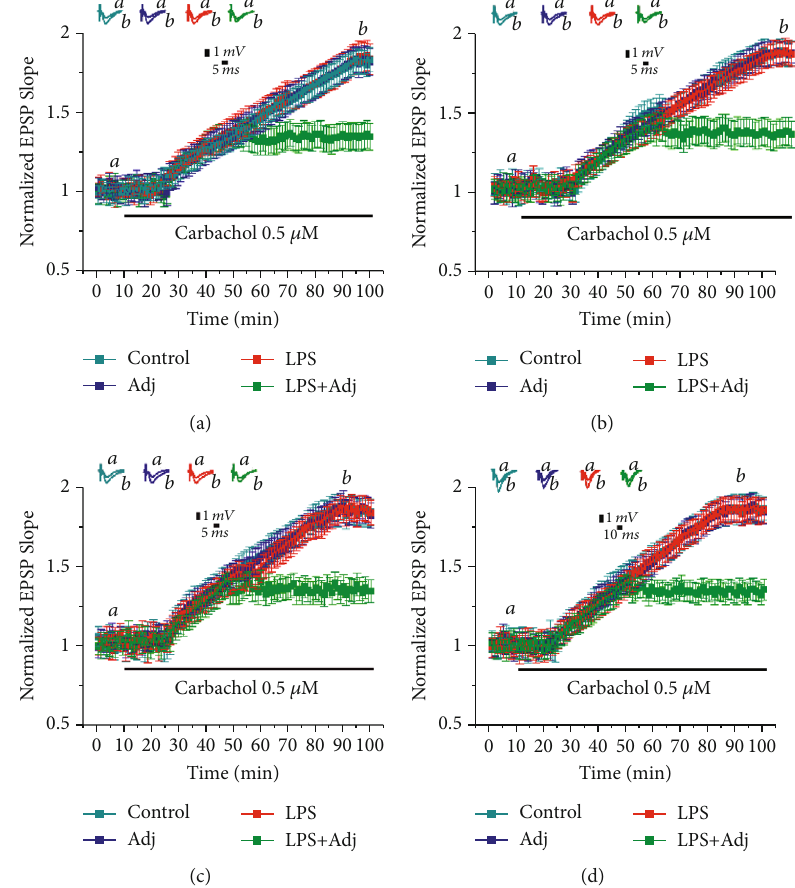
Figure 2: A prolonged treatment with Adj and LPS persistently impairs LTP in the hippocampus. Halting the treatment with Adj+LPS after a month resulted in a persistent impairment of mLTP checking at (a) 1 day, (b) 1 week, (c) 1 month, and (d) two months after treatment interruption. Further details of the results and the statistical comparisons are described in “ Results. ” In each panel of data, the top traces are sample illustrations of original records before (a) and after (b) the application of 0.5 μ M